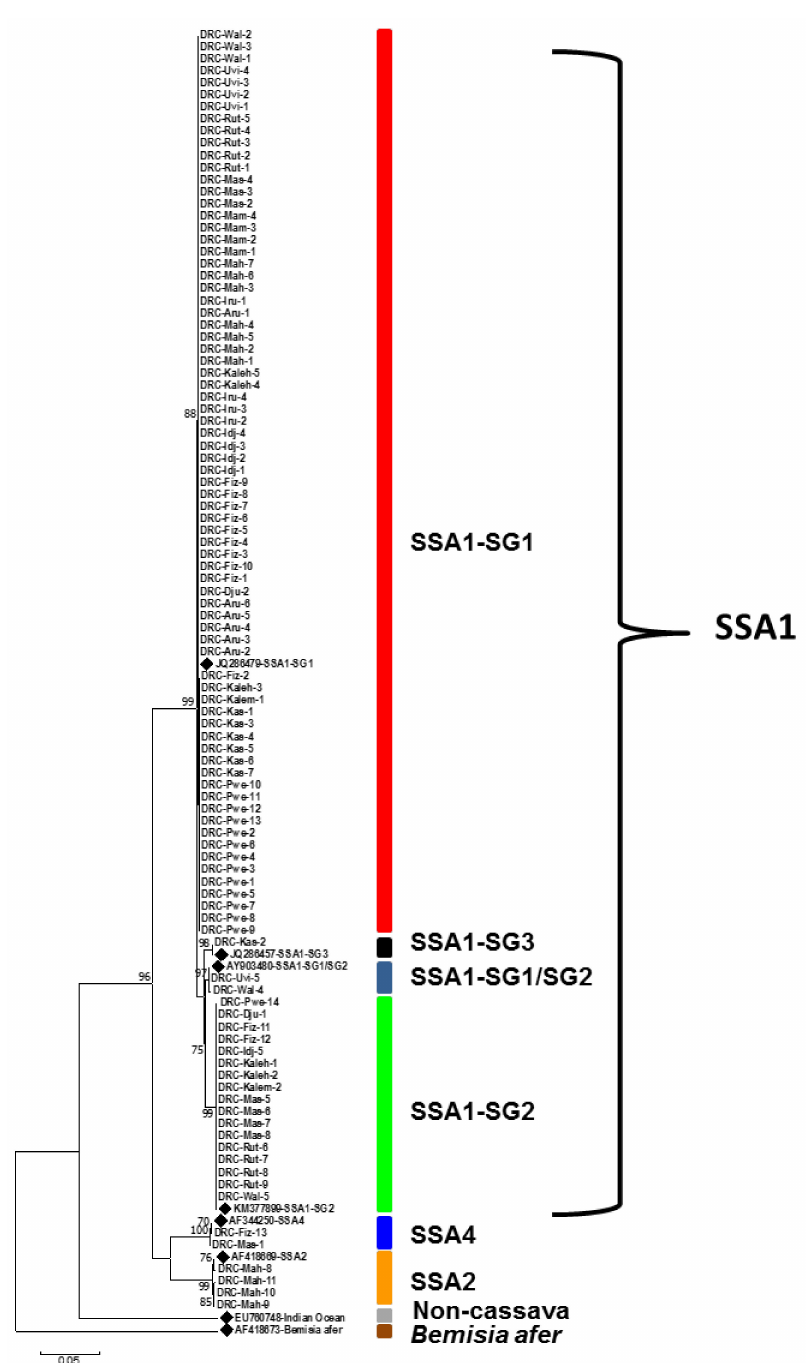
Figure 1. Maximum likelihood phylogenetic tree constructed for COI sequences obtained from Bemisia tabaci collected from eastern Congo between March 2016 and September 2018. Reference sequences from GenBank ( (cid:7) ) are included for